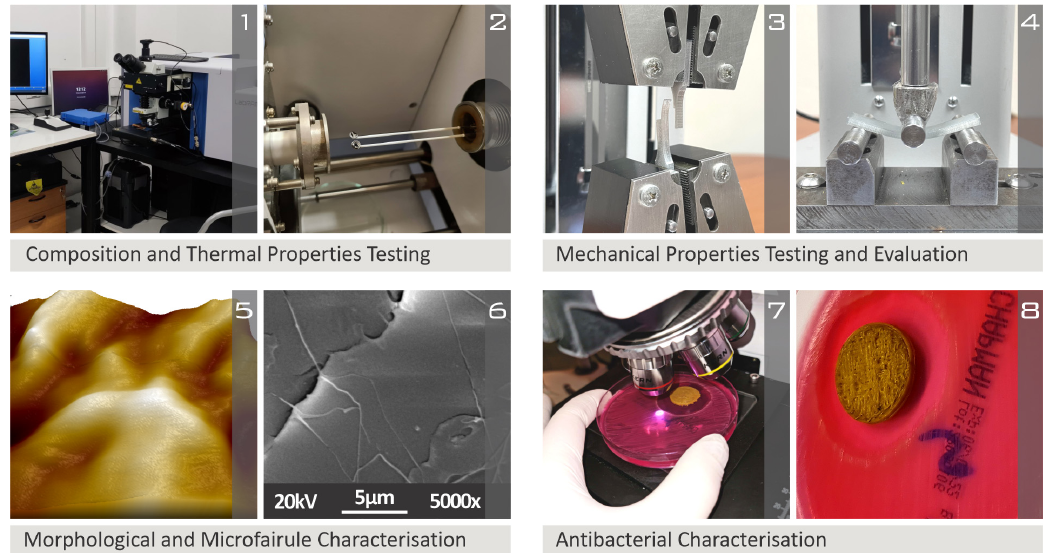
Figure 2. The characterization process for the prepared nanocomposites: (1 ) Raman spectra (LabRAM HR Raman spectrometer), ( 2 ) thermogravimetric analysis (Perkin Elmer Diamond), ( 3 ) tensile test (Imada MX2), ( 4 ) 3-point bending flexural test (Imada MX2), ( 5 ) surface morphology of the filament side surface in atomic force microscopy (Microscope Solver P47H Pro), ( 6 ) morphological investigation with SEM (JEOL JSM 6362LV), ( 7 ) antibacterial investigation with agar well diffusion screening process (inspection of the bacteria cultures with an optical microscope), ( 8 ) inhibition zone developed by a specimen 3D-printed with PLA/0.5 wt.% Cu 2 O nanocomposite by the agar well diffusion screening process on S. aureus